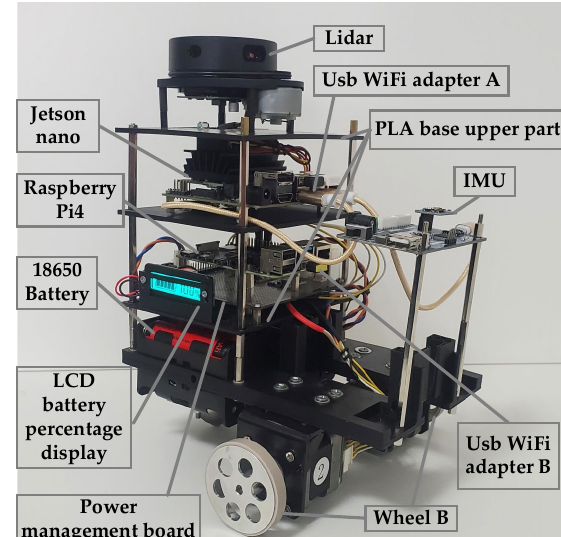
( b ) Figure 2. Motor connections of Owlbot. ( a ) Installation diagram; ( b ) Connection between the step- ping motor, SBC-10 controller, and Raspberry Pi 4B. In the top part, Owlbot has three layers. The first layer incorporates a power man- agement board that can simultaneously output different voltages to satisfy the power re- quirements of various electronic devices. As shown in Figure 3, the power management board can simultaneously output 5 V and 12 V to supply power to the SBC and stepping motor, respectively. The Raspberry Pi unit is connected to the stepping motor driver board, which uses PWM software to generate a PWM signal to drive the stepping motor. The second layer houses the Jetson Nano board, which enables information processing, such as secure shell (SSH) communication with the Raspberry Pi and motion planning. A laser scanner (RPLIDAR A1; Slamtec) for distance measurement is installed in the topmost layer. This laser scanner operates on the principle of laser triangulation and adopts high- speed vision acquisition and processing hardware. The system measures the distance data more than 8000 times per second. The robot is equipped with an IMU at the front end, the data of which can be integrated with the laser data during navigation to achieve precise positioning. Table 2 presents the main hardware composition of the robot platform.